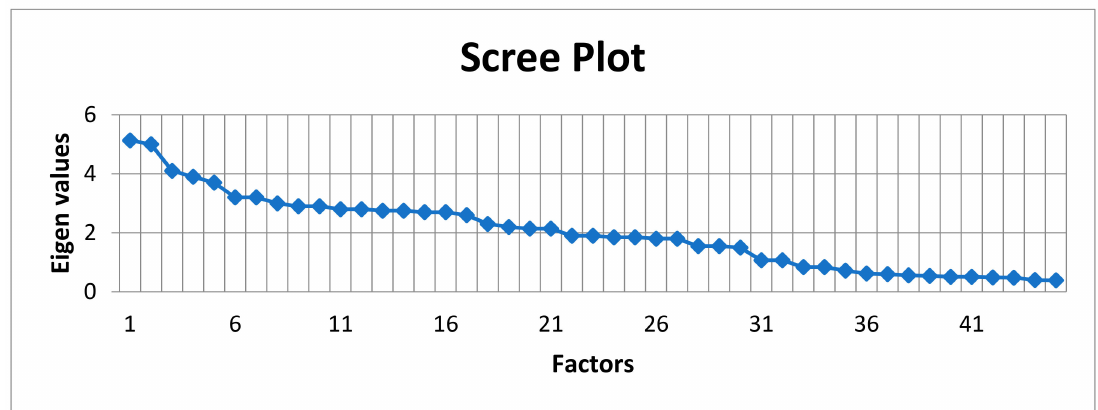
Figure 9. Scree plot defining the number of factors for factor